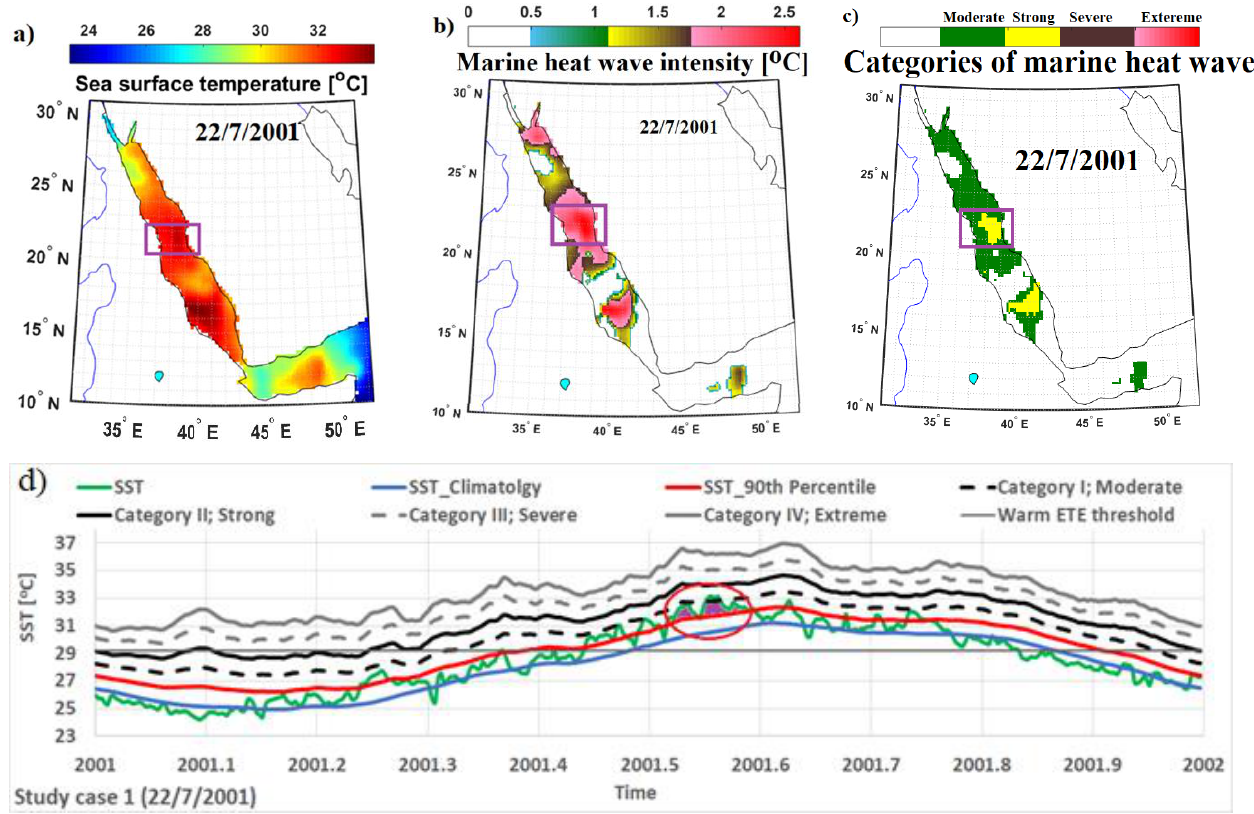
Figure 10. Representative of the MHW event (study case 1) showing the sea surface temperature ( a ), intensity [°C] of marine heat wave event ( b ) and category of that event ( c ) at the peak of the event and the time series during the event’s year ( d ), spatially averaged over an area around the maximum intensity grid, which is shown in bubbles.